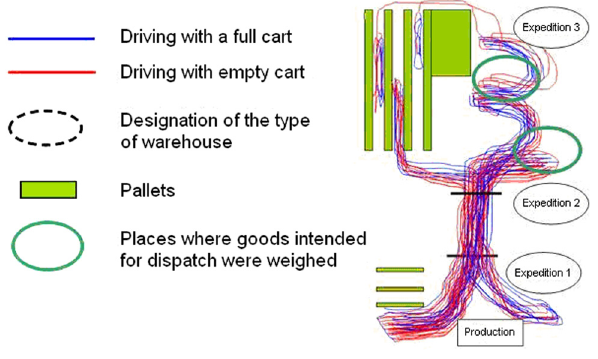
Figure 2: Example of spaghetti